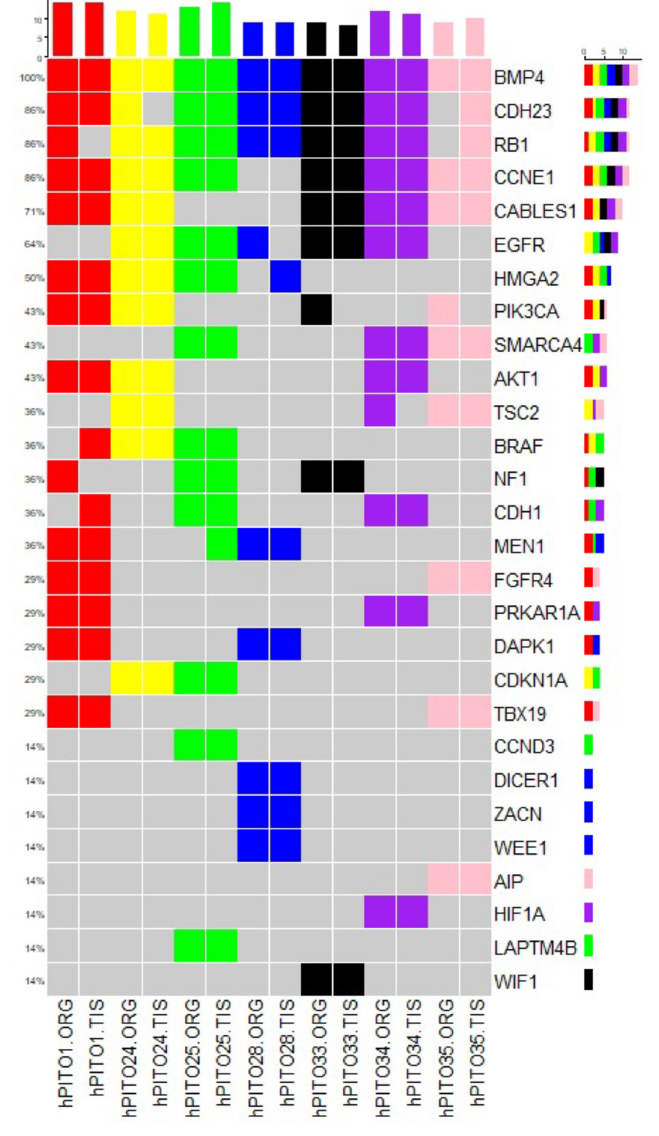
Figure 6. Genomic landscape of hPITOs recapitulates genetic alterations commonly found PitNETs. Overview of single nucleotide variation events detected in hPITOs in genes commonly altered in PitNETs. The mutation frequency across the organoid population is depicted on the right. Color coding of the figure shows that organoid lines are derived from the same patient tumor tissue. ORG: organoid line, TIS: matched patient’s PitNET tissue.